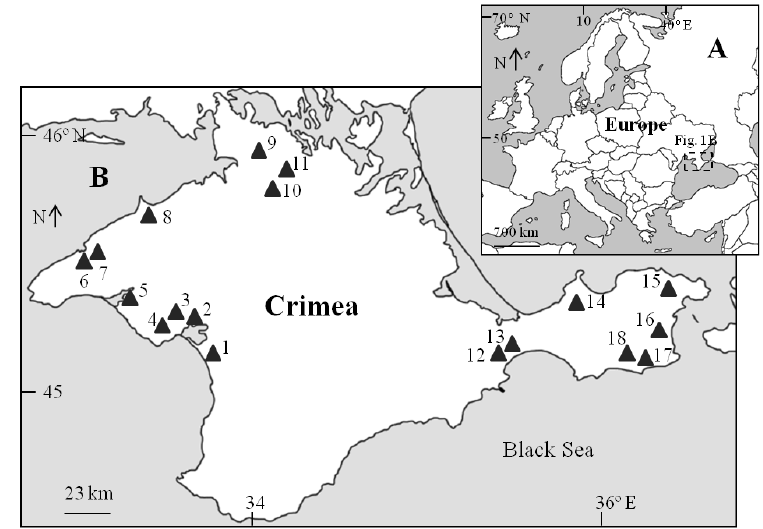
Figure 1. Distribution of the studied saline lakes in Crimea (1 — Novofedorovskoe, 2 — Kyzyl-Yar,